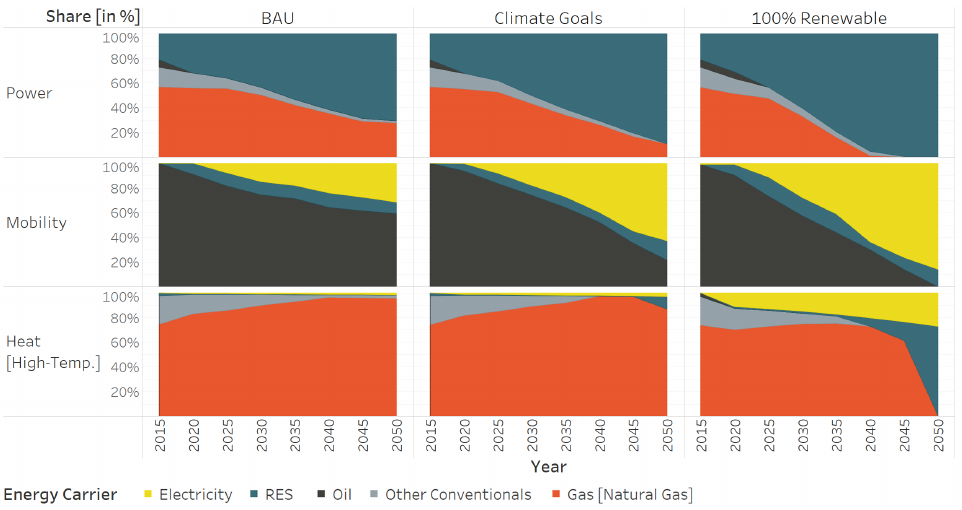
Figure 10. Share of Renewable Energy Sources per sector and